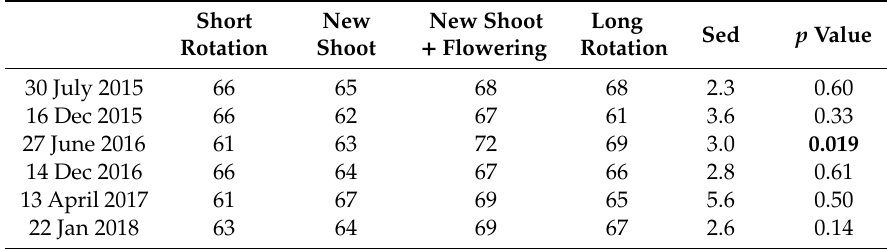
Table 4. Basal cover (%) of SARDI 7 lucerne during the three years of study at Hamilton, from December 2014 until January 2018. Pre-defoliation treatment basal cover, assessed at November 2014, was used as a covariate in all the assessments. All analyses had 11 residual degrees of